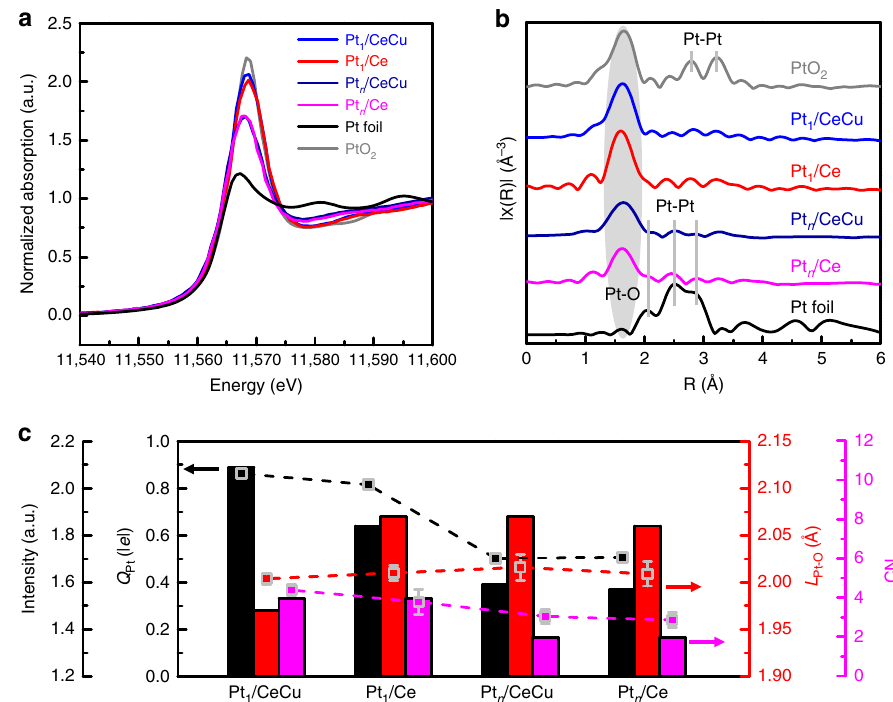
Fig. 3 Interfacial structures characterizations of catalysts. a Normalized Pt L III -edge XANES and ( b ) k 2 -weighted Fourier-transformed EXAFS spectra of Pt 1 /CeCu, Pt 1 /Ce, Pt n /CeCu, Pt n /Ce, Pt foil and PtO 2 . c Q Pt , calculated Bader charges of interfacial Pt atoms; L Pt – O , bond lengths between Pt atoms and interfacial oxygen; and CN Pt – O , coordinate number of interfacial Pt atoms, of Pt 1 /CeCu, Pt 1 /Ce, Pt n /CeCu and Pt n /Ce. The black square points are the white line intensity from XANES spectra. The red and magenta square points representing L Pt – O and CN Pt – O are the fi ts to the EXAFS spectra. Source data are provided as a Source Data fi